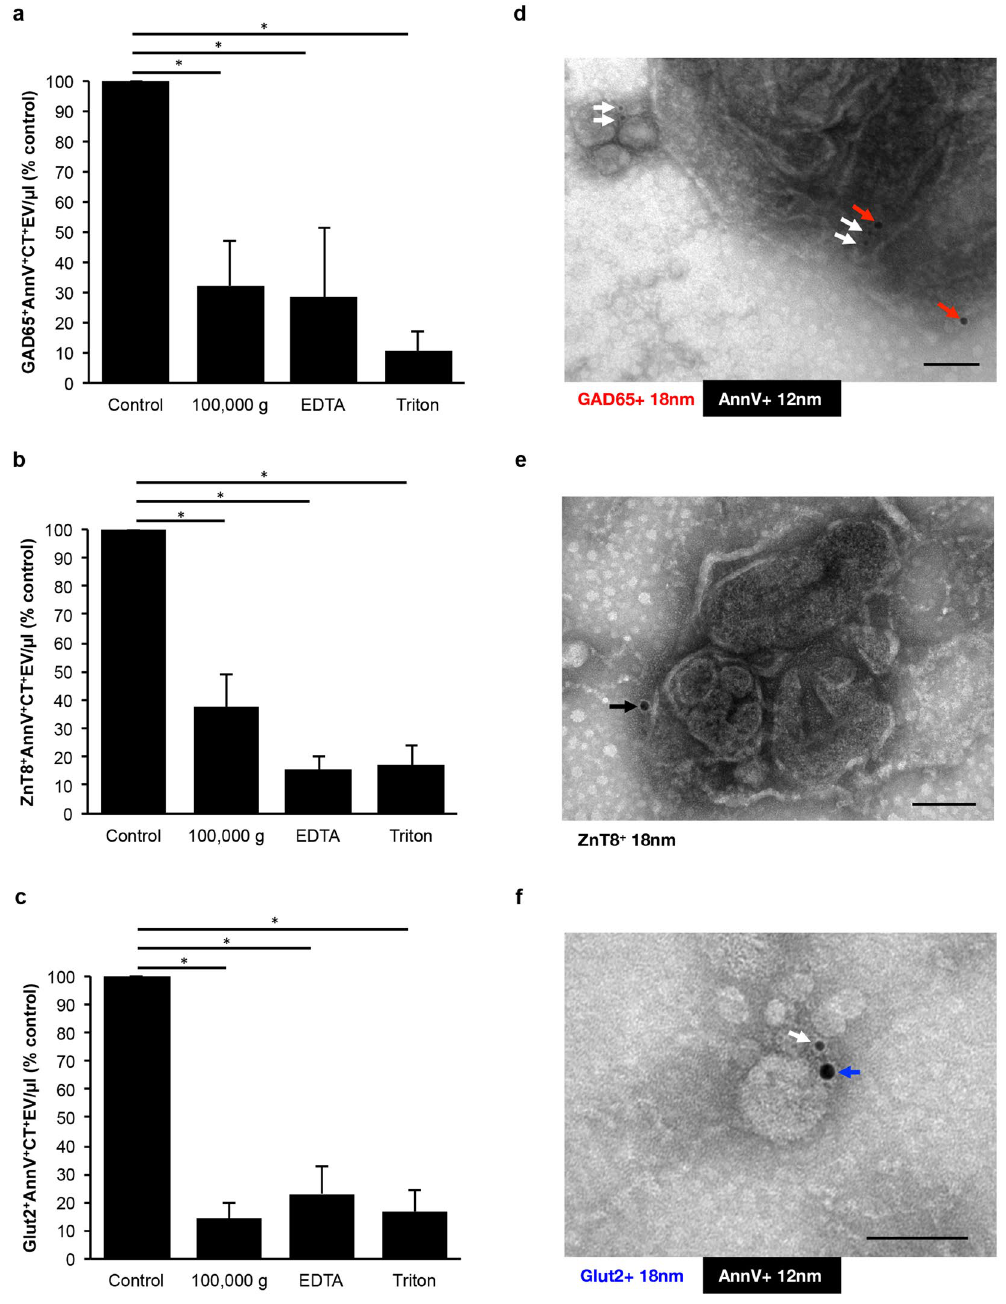
Figure 6. Diabetes autoantigens and β -cell markers are present on extracellular vesicles produced by non- diabetic donors. ( a – c ) Bar graphs of islet conditioned media (ICM) compared to signal depletion by 100,000 g centrifugation, 50 mM EDTA, or 0.3% Triton X-100 for GAD65 + AnnV + CT + EV ( a ), ZnT8 + AnnV + CT + EV ( b ), and Glut2 + AnnV + CT + EV ( c ). ( d – f ) Micrographs of immunogold double labeled islet-derived EV preparations from fractionated ICM confirms the presence of AnnV (white arrows), GAD65 (( b ) red arrows), ZnT8 (( d ) black arrow) and Glut2 (( f ) blue arrow). Data are expressed as mean ± SEM from n = 4 human islet preparations from different donors. * p < 0.05, repeated measures one-way analysis of variance with Tukey’s post-hoc test performed on raw values prior to conversion to percent of control. Scale bars represent 100